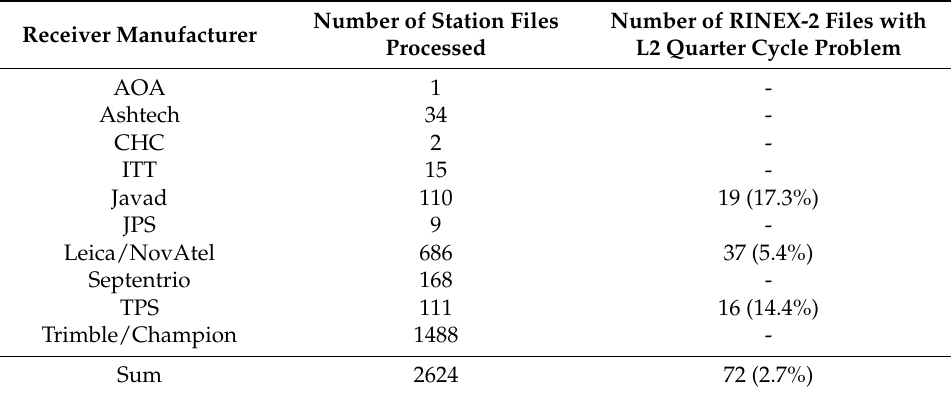
Table 4. Detection Results by Receiver